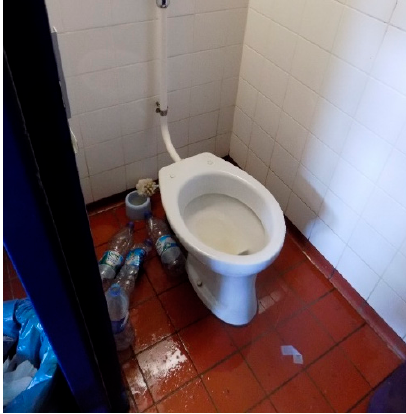
Figure 3. Empty water bottles that were previously used for cleansing.